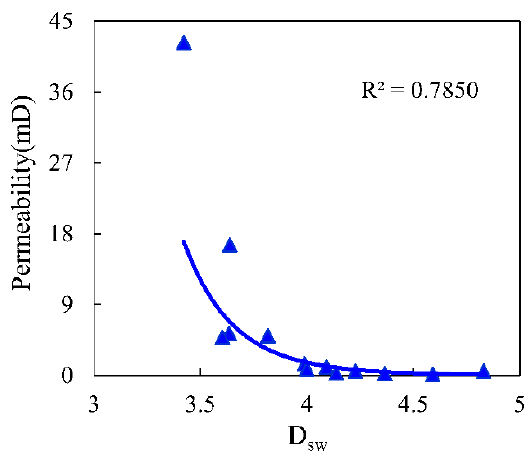
Figure 8. A plot of D sw vs. permeability.